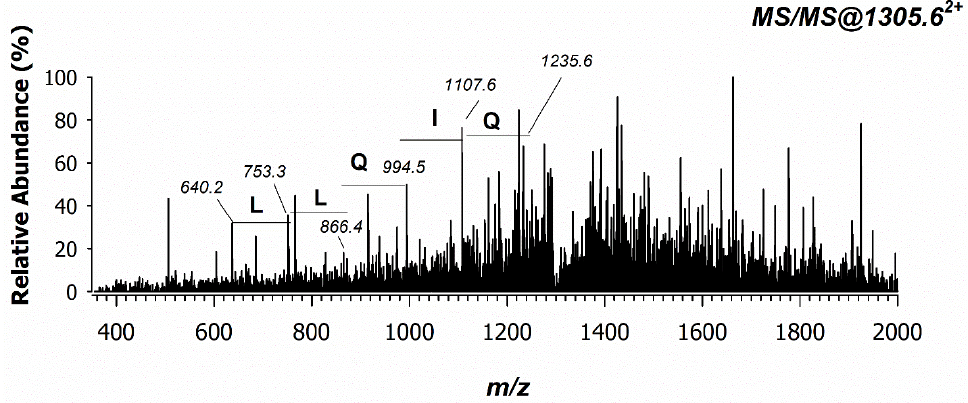
Figure 9. ESI MS/MS mass spectrum of the doubly charged precursor ion at m/z 1305.6 2+ observed in the PAT-treated sample and generated from the cyclic peptide formed by intramolecular bonds between PAT and two -SH groups of cysteines 136 and 155 of the sequence C LLQIQASSGKNKYSGTLD C AKK.